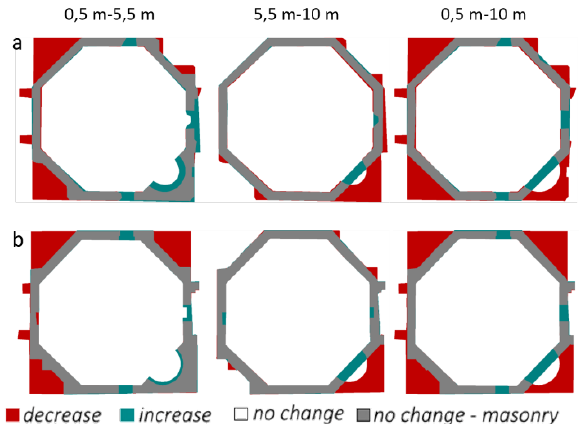
Figure 11. “Vertical” comparisons for each model: (a) the current model and (b) the historical